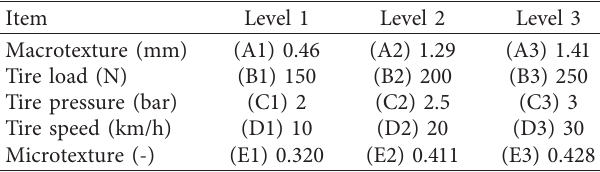
Table 5: Levels of the variables of the orthogonal